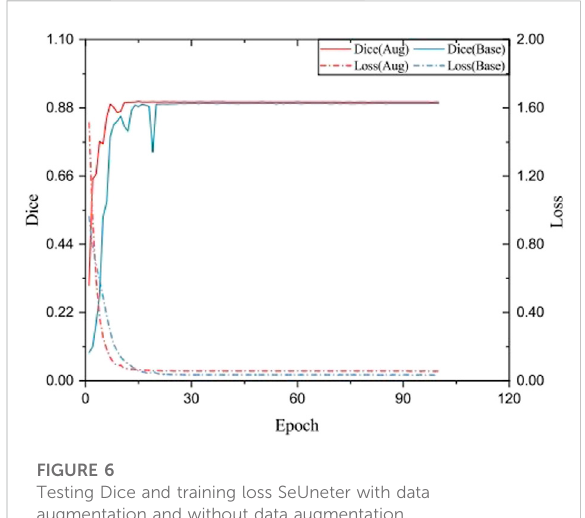
FIGURE 6 Testing Dice and training loss SeUneter with data augmentation and without data